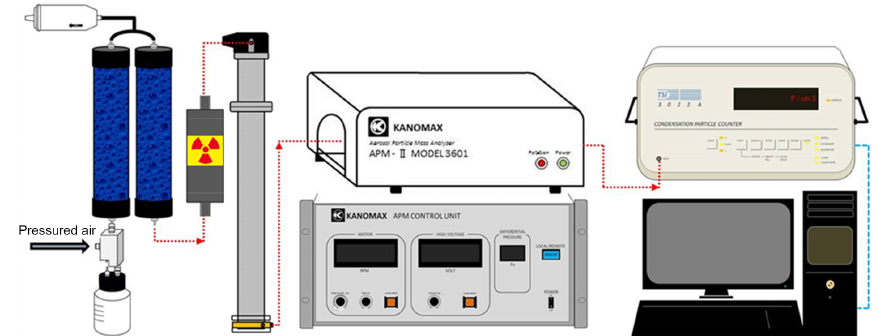
Figure 4. Experimental DMA–APM